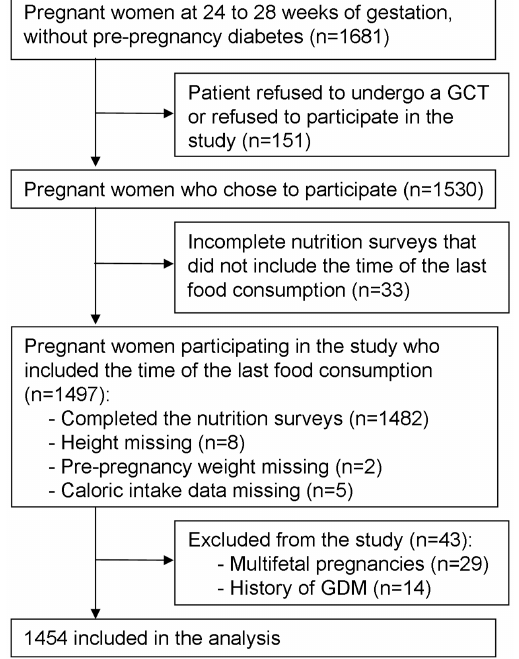
Figure 1. Flowchart of methods.